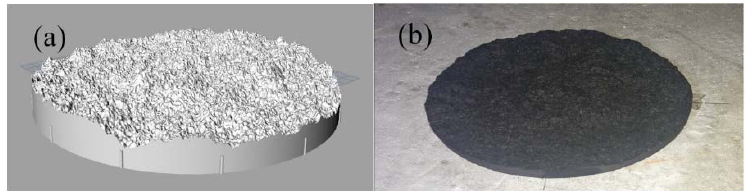
Figure 2. Geometry Configuration of the 3D model and the fabricated sample of the exponentially correlated rough surface. ( a ): CAD model; ( b ): Fabricated sample.